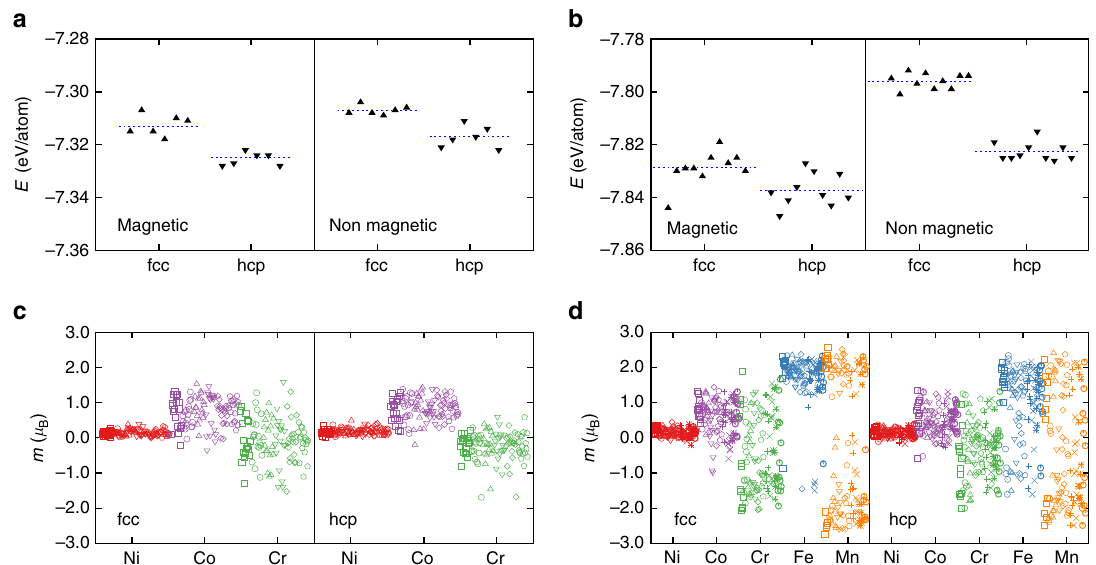
Fig. 3 Magnetic effects on the energies of hcp and fcc phases in CrCoNi and CrMnFeCoNi. a , b The total energy of fcc and hcp phases for the two alloys with and without spin polarization. Different random distributions of each composition are achieved by permuting atom types in a fcc or hcp SQS cell, resulting in 6 and 10 permutations for the ternary and quinary alloys respectively. Average energies are indicated by the dashed lines. In CrCoNi, the hcp phase is always favored with respect to fcc, even without spin polarized calculations. c , d The magnetic moments per atom for all calculations in the ternary and quinary alloy, respectively. The quinary alloy experiences a strong magnetic frustration, that results in an overlap between hcp and fcc